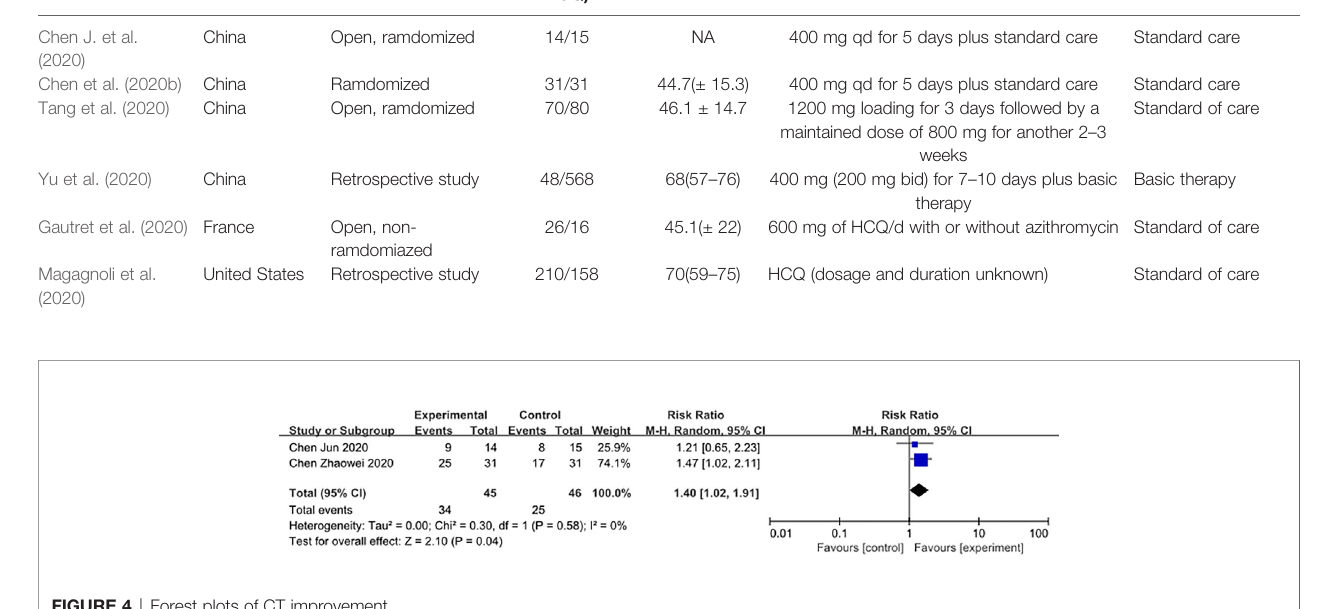
FIGURE 4 | Forest plots of CT improvement.